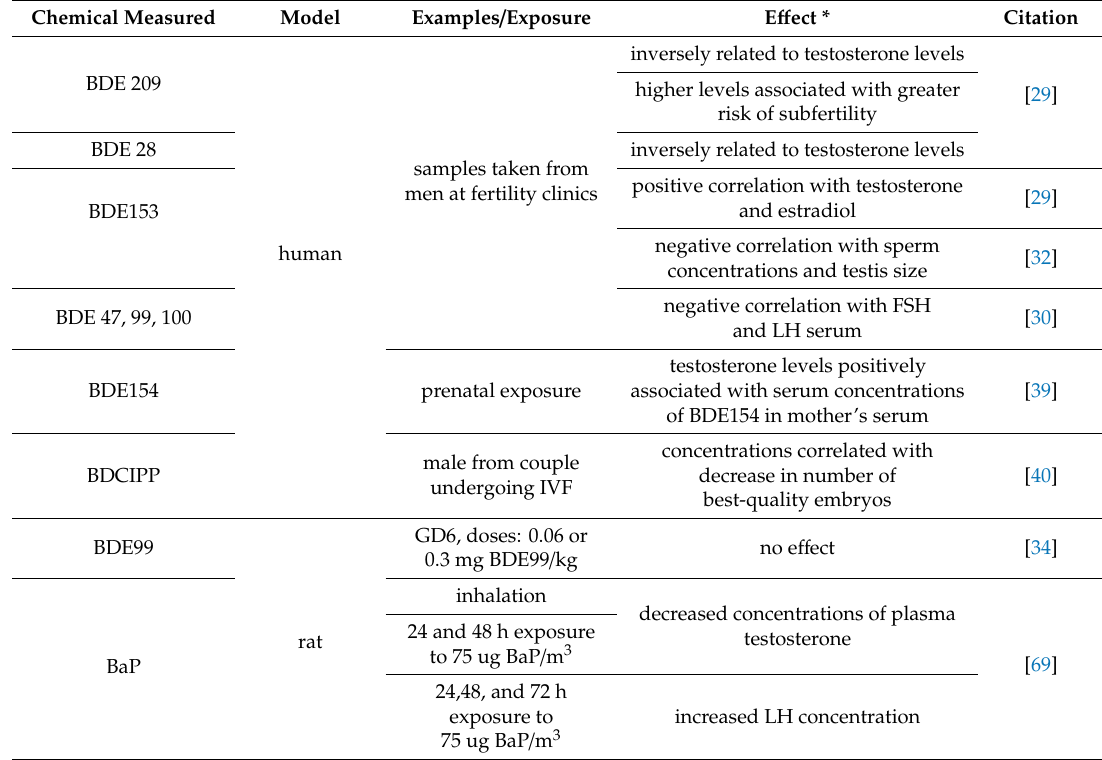
Table 1. Summary of Inhalable Endocrine-Disrupting Chemicals and Female-Specific E ff ects in Multiple Animal